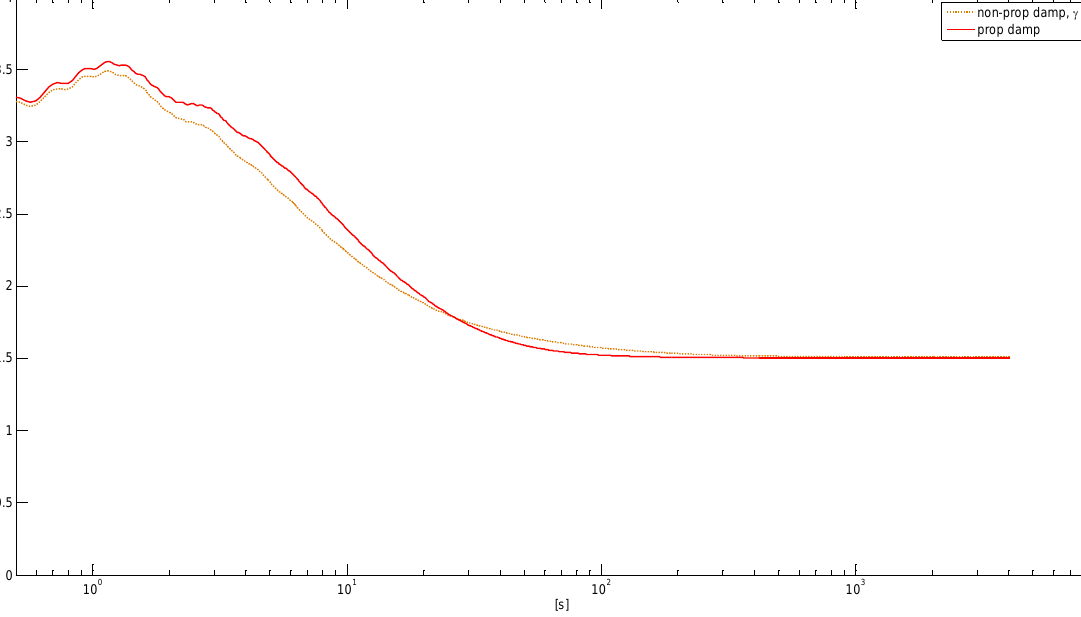
− since   , the motion of the focus is over damped and the slope of the curve is much stepper than the r others, as predicted by Eq.